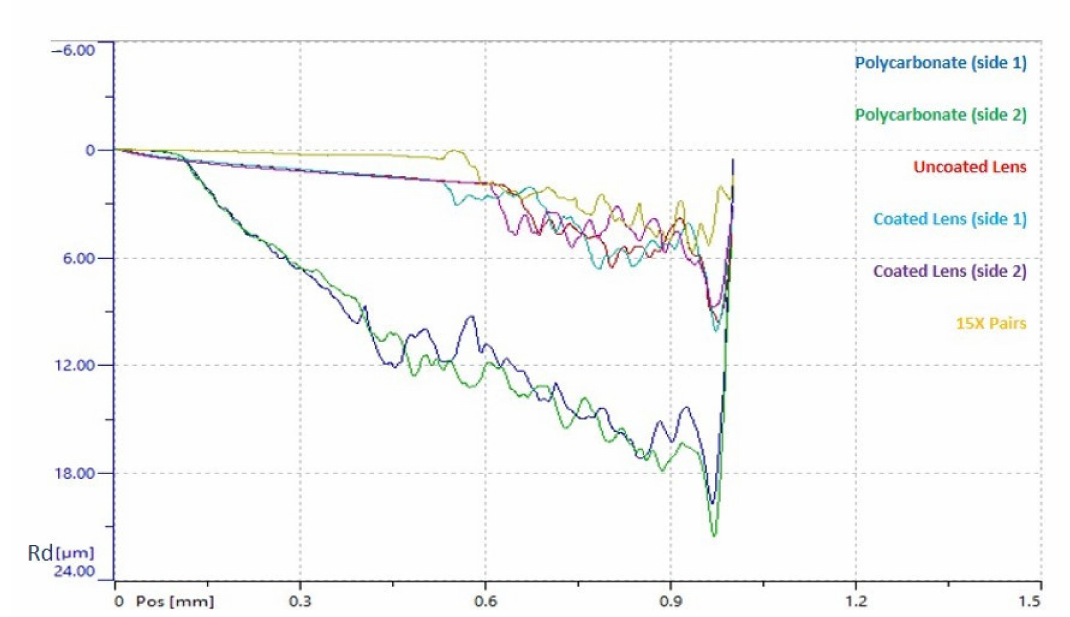
Figure 6. Comparative Curves Mean residual depth curves (permanent plastic deformation) measured after scratching the surface for four samples (15 bi-layered coated sample, uncoated and coated glass lenses, and polycarbonate). ‘Rd’ (y-axis) refers to residual depth of the scratch ( µ m); ‘Pos’ (x-axis) refers to position or distance from the starting point of the scratch (mm). Table 1. Hardness and Elastic Module Comparative table. Hardness Module (H IT in MPa) data for each sample (both sides of a Polycarbonate sheet (Sample 1), where the marked side Woodward was scratch-resistant-coated, an uncoated lens (Sample 2), both sides of a dip coated lens (Sample 3) and a 15 × bi-layered coating) was measured six times and the mean and standard deviation calculated. Likewise, the same approach was taken for the elastic modulus data (E IT in GPa). Hardness &